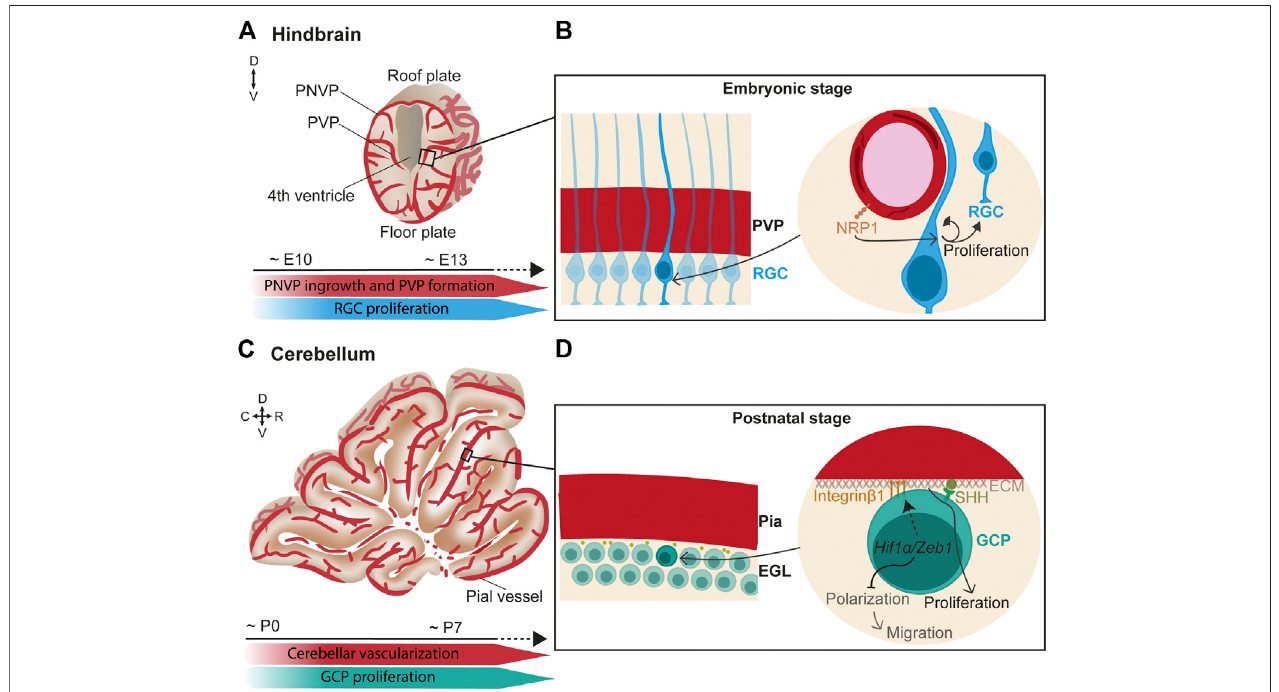
FIGURE 1 | Endothelial cell signaling regulates neurogenesis in the hindbrain/cerebellum. (A) (Top) Scheme of a coronal view of the hindbrain at the embryonic stage. Vessels from the perineural vascular plexus (PNVP) ingress into the neural tissue in a perpendicular manner towards the ventricle where they form the periventricular vascular plexus (PVP). Then, lateral sprouts emerge and form a more complex vascular network. (Bottom) Timeline of concurrent hindbrain embryonic vascularizationandradialgliacells(RGC)proliferation. (B) (Left)Closerviewoftheventricularzonecontainingalayerofradialglialcells(RGC)thatextendtheirbasal fi berstowardsthepialsurfaceandtheapicalshortprocessescontacttheventricle.(Right)RGCbasal fi bersdirectlycontactthePVPvessels.Inthisscenario,endothelial NRP1 signaling maintains RGC proliferation through a mechanism independent of hypoxia and VEGF. (C) (Top) Scheme of a sagittal view of the cerebellum at the fi rst postnatal week. (Bottom) Timeline of concurrent cerebellar postnatal vascularization and granule cell progenitors (GCP) proliferation. (D) (Left) Granule cell progenitors (GCP) reside under the pial vessels in the cerebellum and form the external granule layer (EGL). (Right) In hypoxic conditions, Hif1 α /Zeb1 favors the GCP attachment to the extracellular matrix (ECM) of the pial surface through Integrin β 1 expressed at the GCP membrane. In parallel, Hif1 α /Zeb1 inhibit GCP polarization and subsequent migration. Components of the pial ECM (laminins) enhance SHH signaling which, in turn, promotes GCP proliferation.